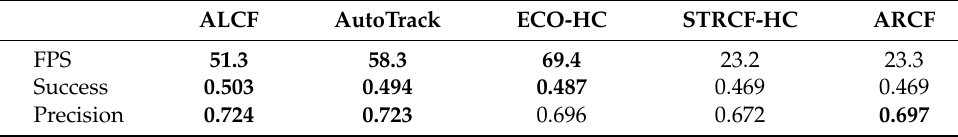
Table 1. Average speed (FPS) of top five trackers on [39–42], ranked by average success (top 3 in bold ).